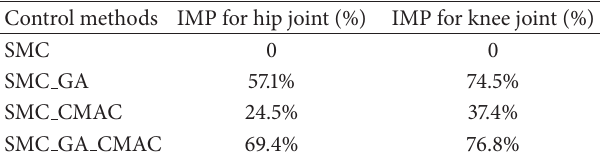
Table 1: Accuracy improvement comparison (Case One). Table 2: Accuracy improvement comparison (Case